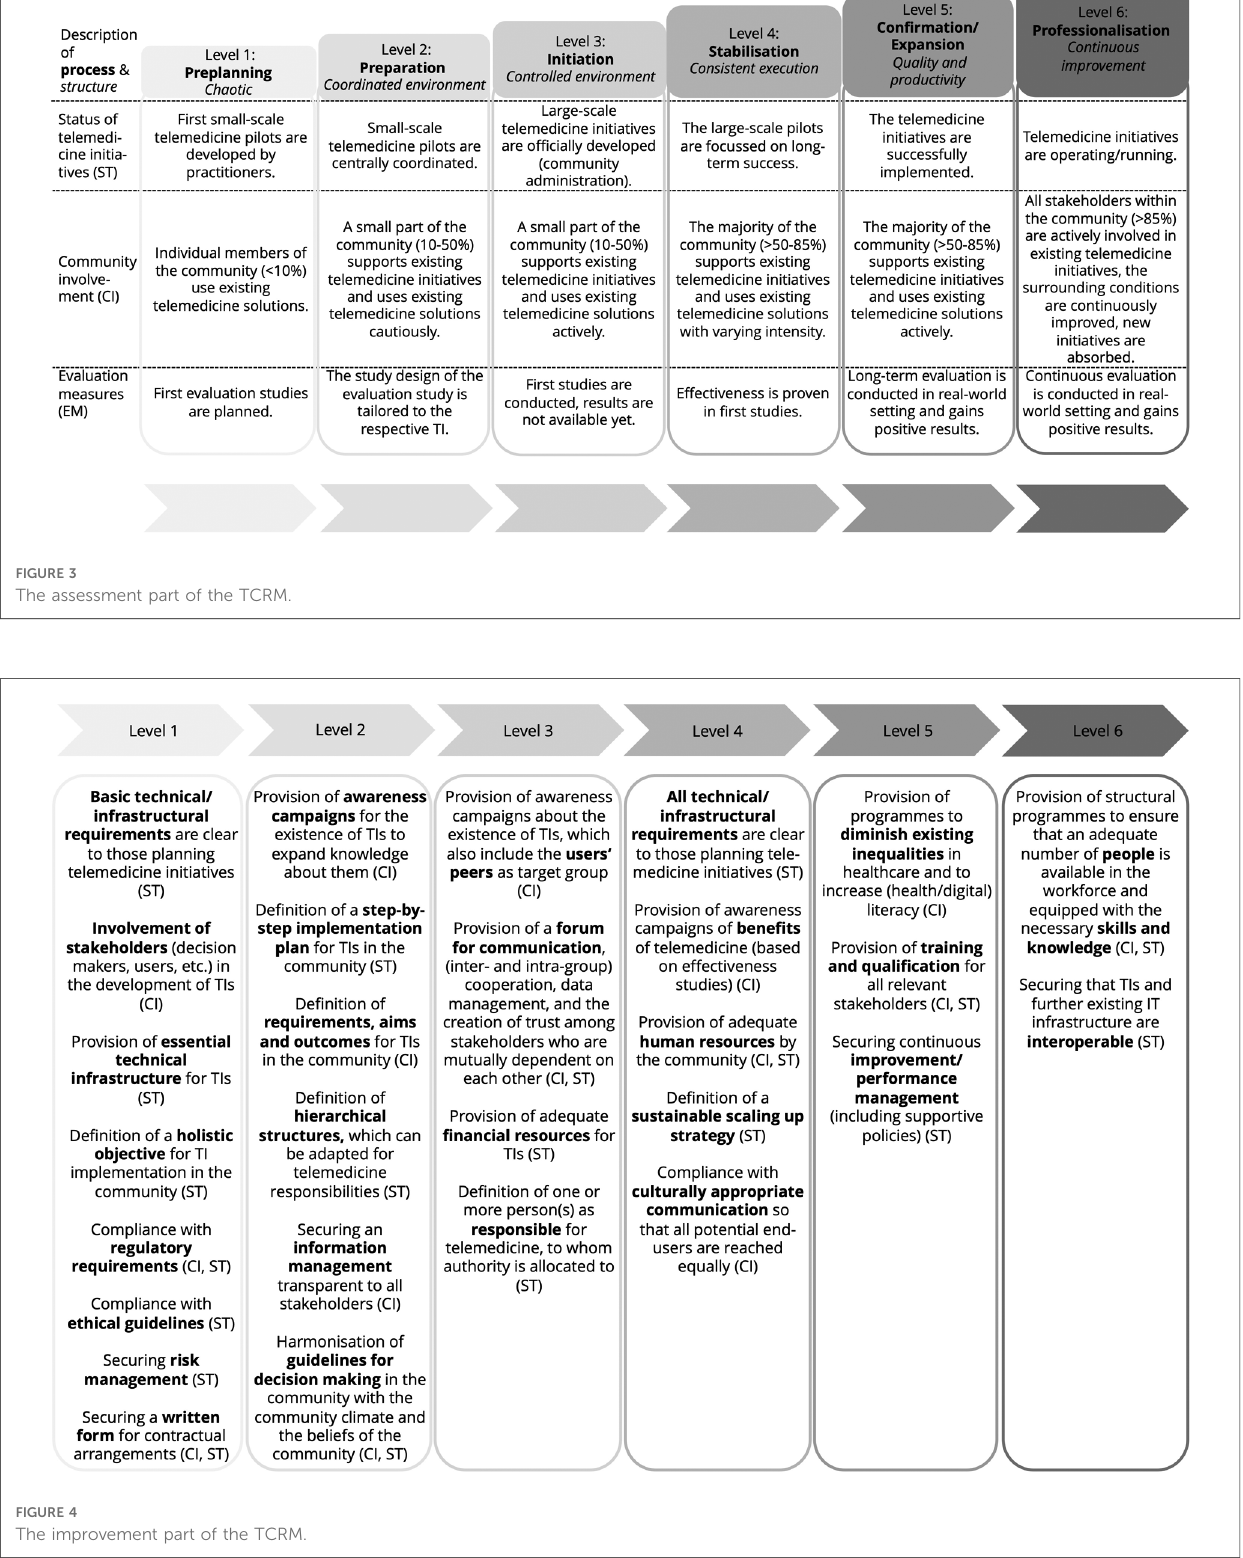
FIGURE 4 The improvement part of the